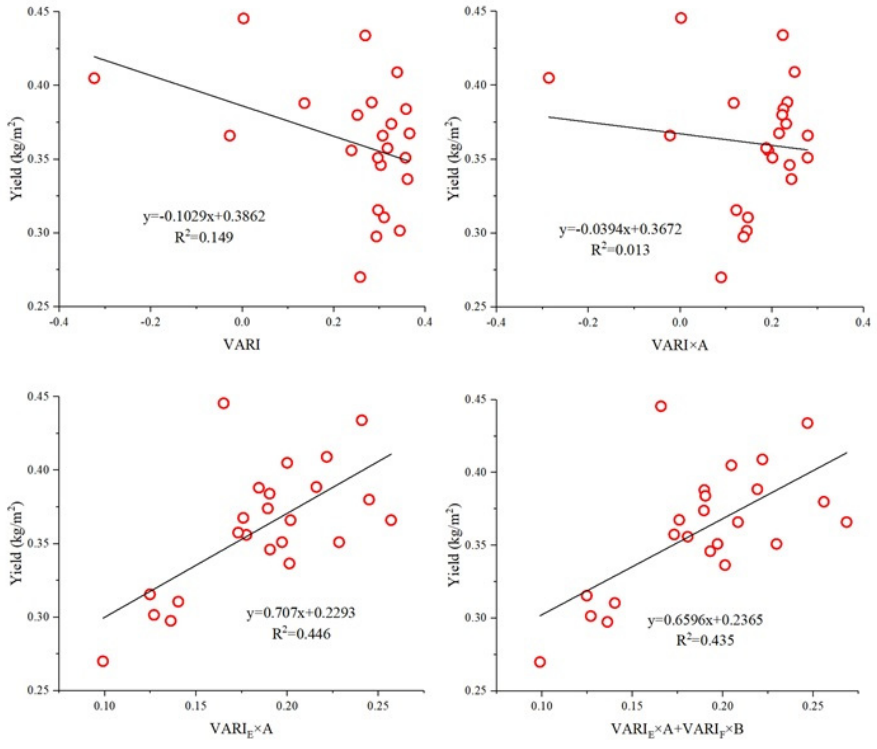
Figure 13. The linear regression results of yield and the four products of VARI in Study Area 2 Wuxue.